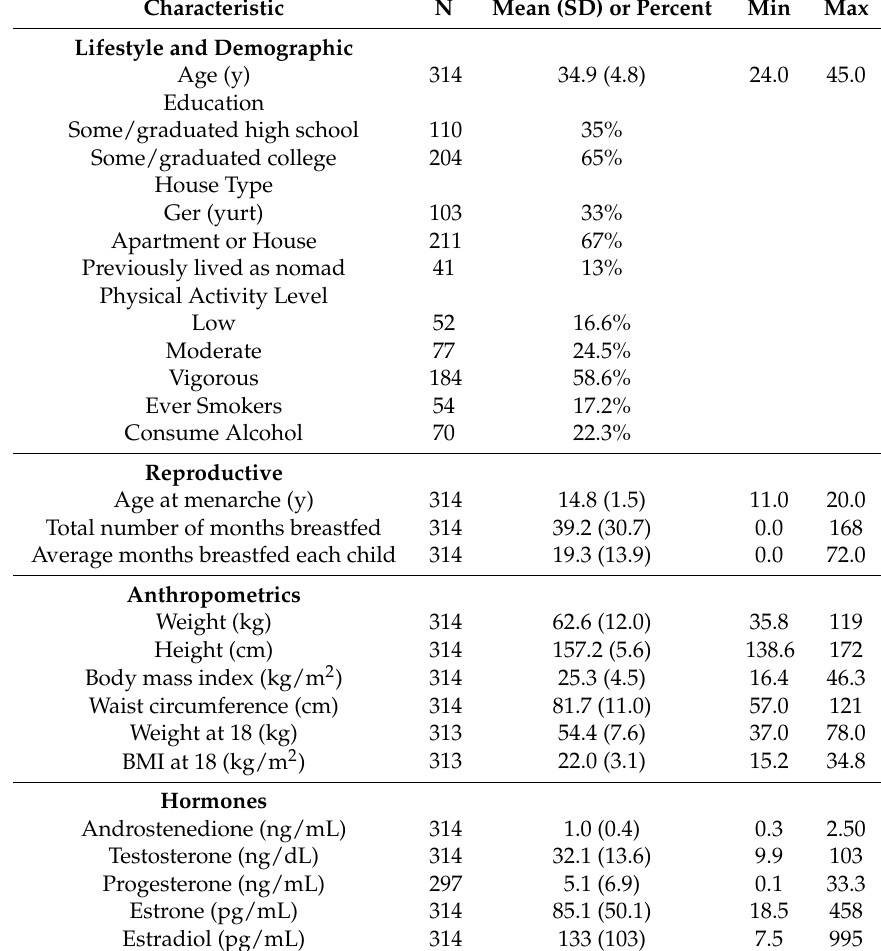
Table 1. Demographic, lifestyle, reproductive and anthropometric characteristics, and hormone concentrations among 314 premenopausal Mongol